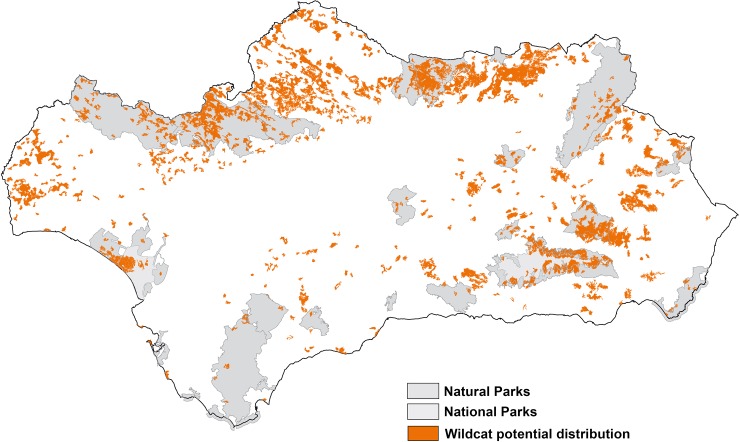
Wildcat potential distribution in the study area modelled with MaxEnt (patches of more than 228 hectares, see text for further details).